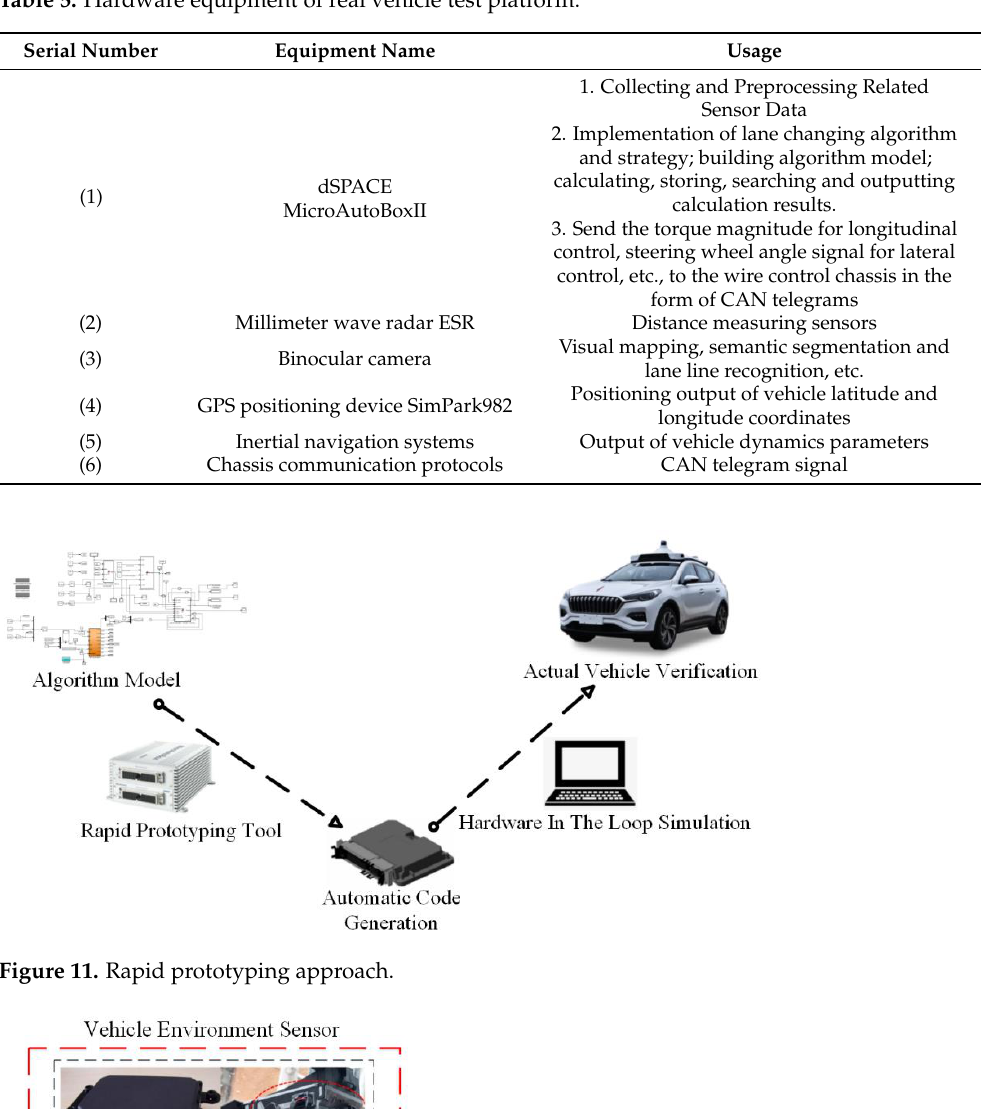
Table 5. Hardware equipment of real vehicle test platform.